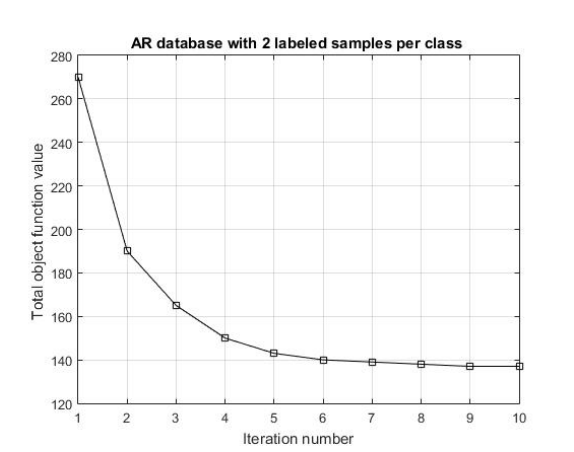
Fig. 1 Total objective function value on the AR database [37] versus number of iterations.